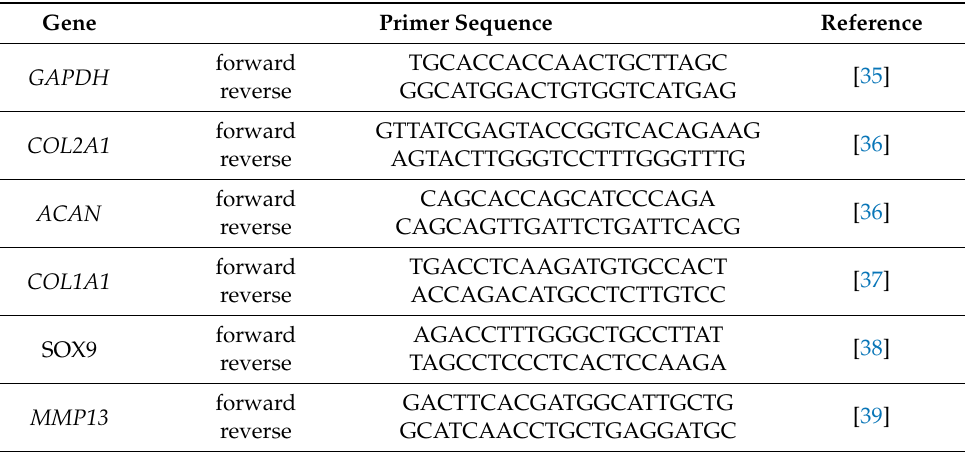
Table 2. Used primers with sequences and